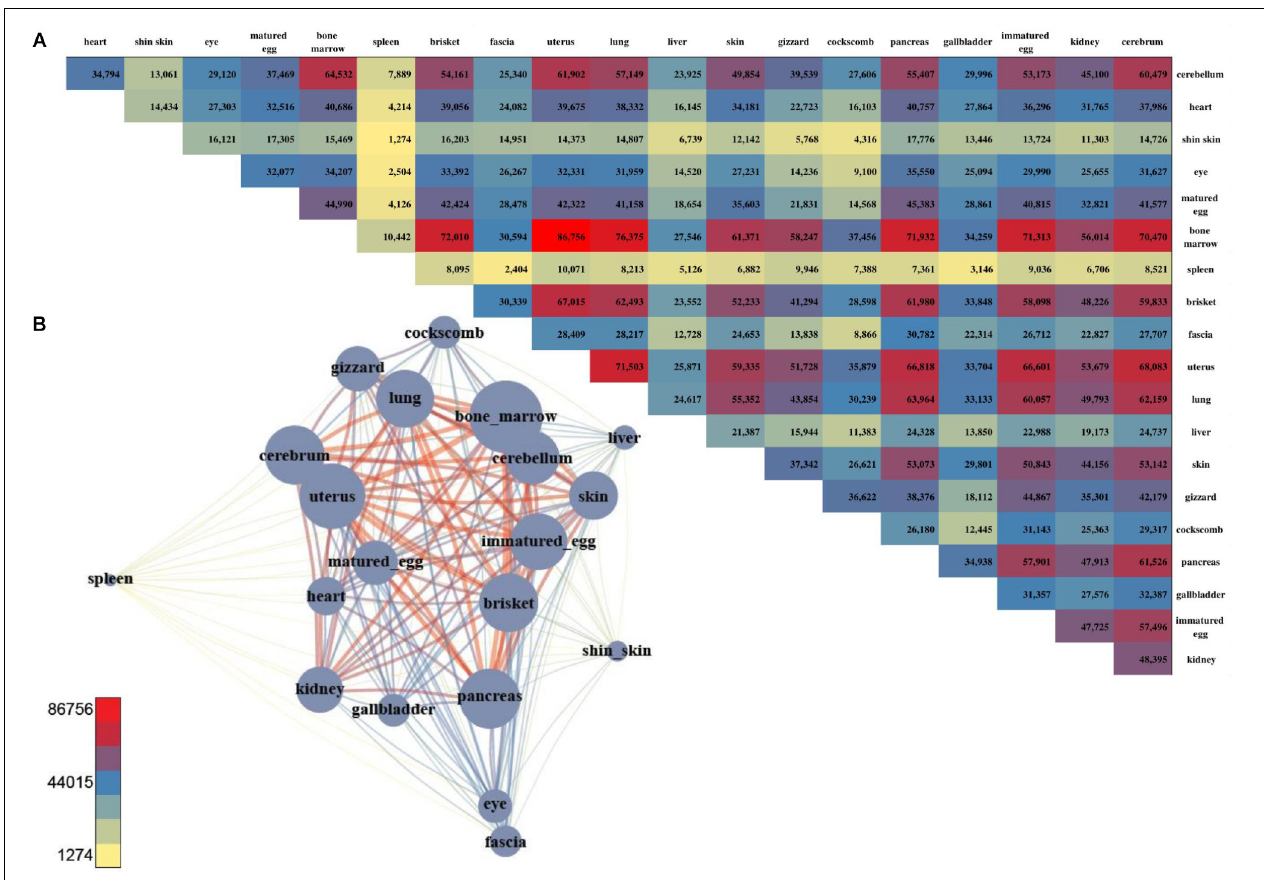
FIGURE 4 | The number of DMS and the pair-wise comparison of the 20 tissues. (A) The number of DMSs that were compared with each other among the 20 tissues. (B) Network created using the DMSs. The total number of DMSs in any pair-wise condition is represented by a node, and the number of DMSs in the condition indicated by an